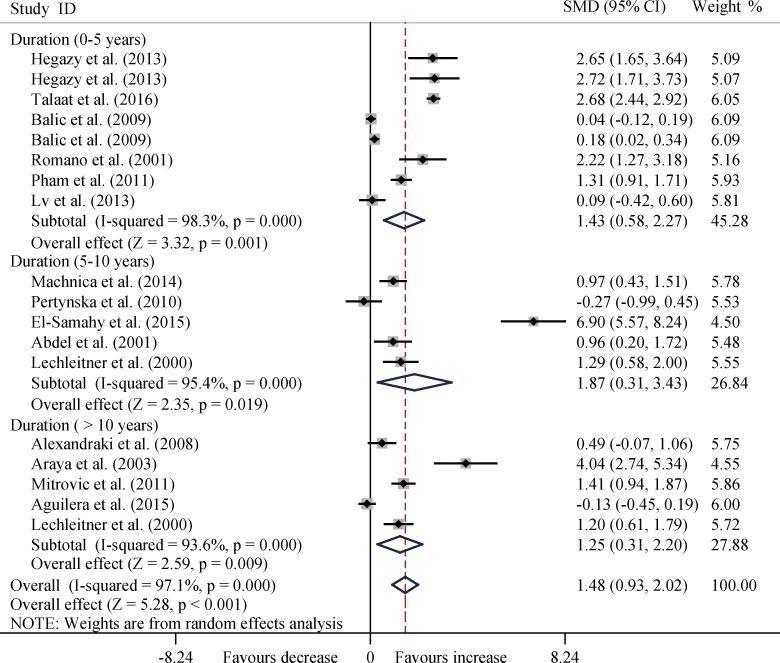
Forest plots about subgroup analysis for the level of TNF-α between T1DM patients and controls with random effects model among different disease duration groups.Duration, 0–5 years, SMD, 1.43, 95% CI, 0.58 to 2.27, P = 0.001; Duration, 5–10 years, SMD, 1.87, 95% CI, 0.31 to 3.43, P = 0.019; Duration, > 10 years, SMD, 1.25, 95% CI, 0.31 to 2.20, P = 0.009; Overall, SMD, 1.48, 95% CI, 0.93 to 2.02, P < 0.001.